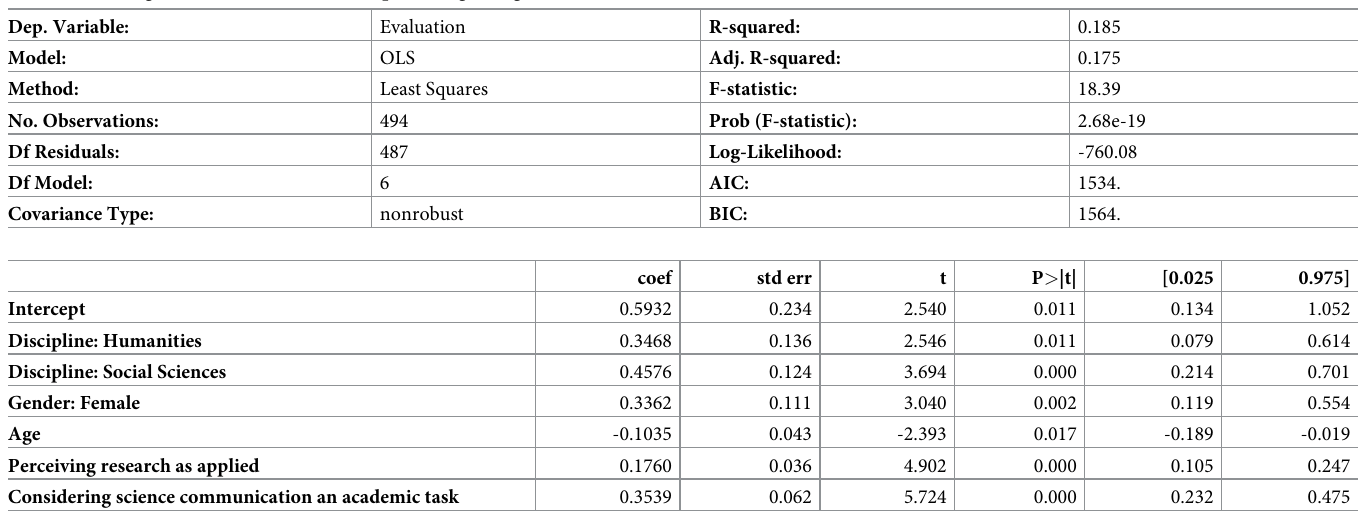
Table 1. OLS Regression on the researchers opinion regarding